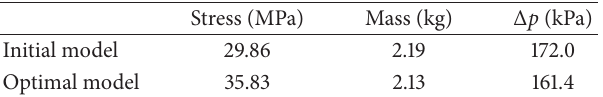
Table 7: Comparison of the performance between the initial and optimal